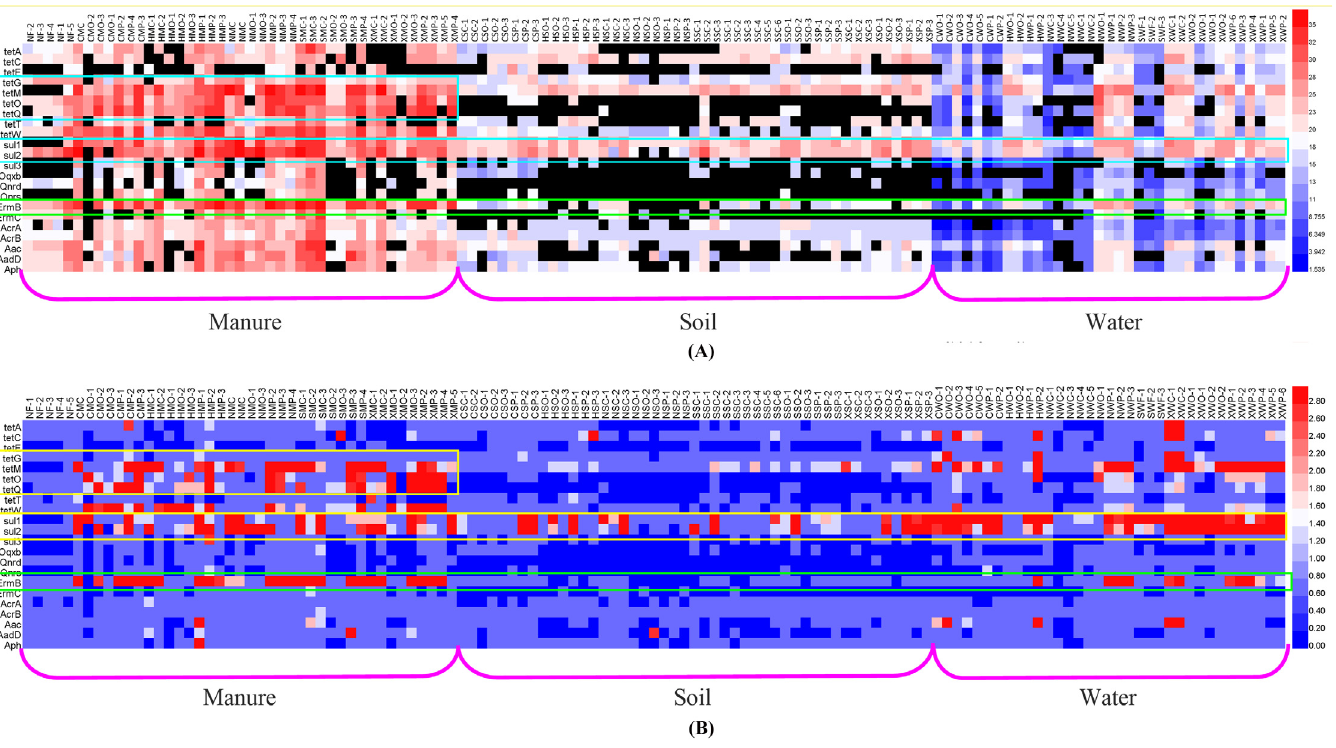
Fig 1. Heatmap of the absolute (A) and relative (B) concentration of the targeted ARGs in manure, soil and water samples. (Columns show the ARGs concentrations, and red indicates an increase in gene abundance, whereas blue indicates a decrease. No change corresponds to 0 in the color